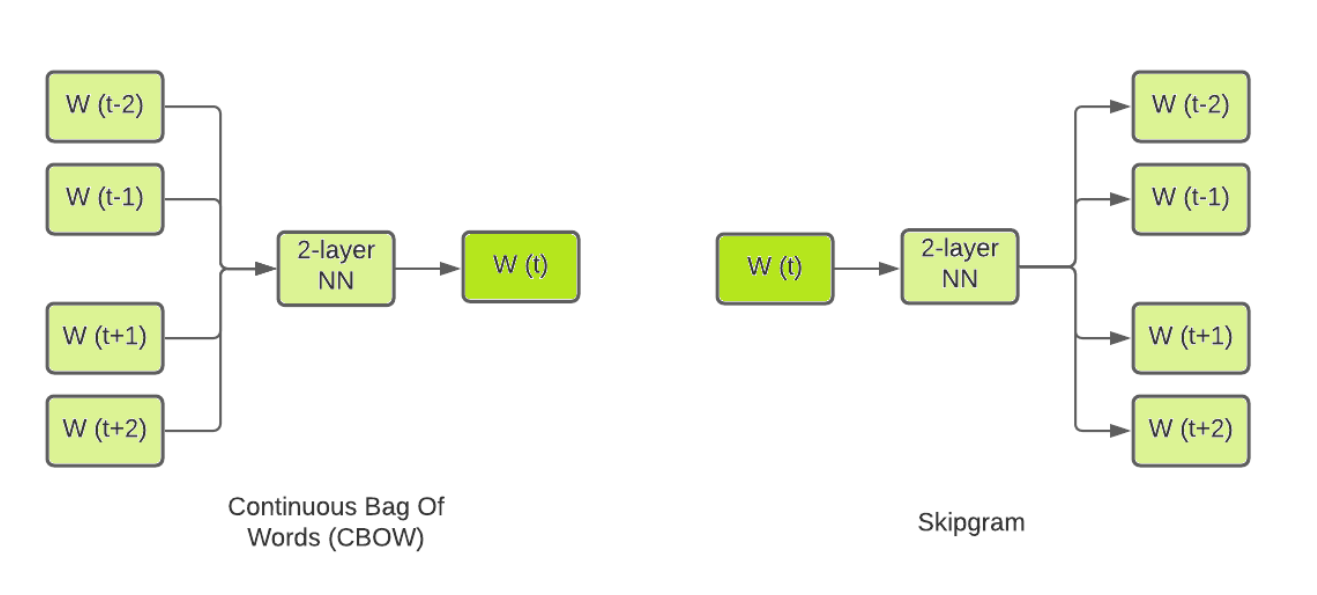
Figure 3. An illustration of the flow of data in the CBOW ( left ) and Skipgram ( right ) training